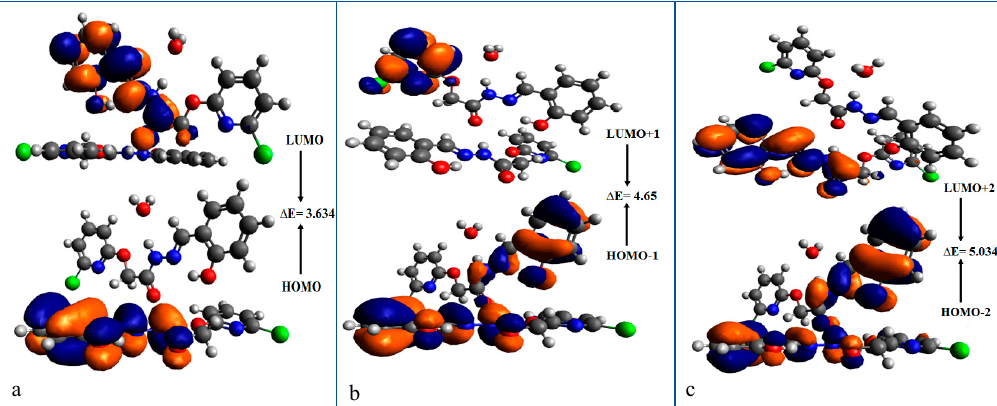
Figure 10. Frontier molecular orbitals (FMOs) for HBPAH. ( a ) E HOMO , E LUMO , ( b ) E HOMO-1, E LUMO + 1 , and ( c ) E HOMO-2 , E LUMO + 2 , molecular orbitals. d energy gap ( ∆ E ) in shown in eV of the entitled compound at the DFT / B3LYP / 6-311G (d,p) level of theory. Table 6. The E HOMO , E LUMO , E HOMO-1, E LUMO + 1 , E HOMO-2 , E LUMO + 2 , and energy gap ( ∆ E ) in eV of the entitled compound at the DFT / B3LYP / 6-311G (d,p) level of theory. HBPAH MO(s) Energy ∆ E(eV) HOMO − 5.600 3.634 LUMO − 1.966 HOMO-1 − 6.266